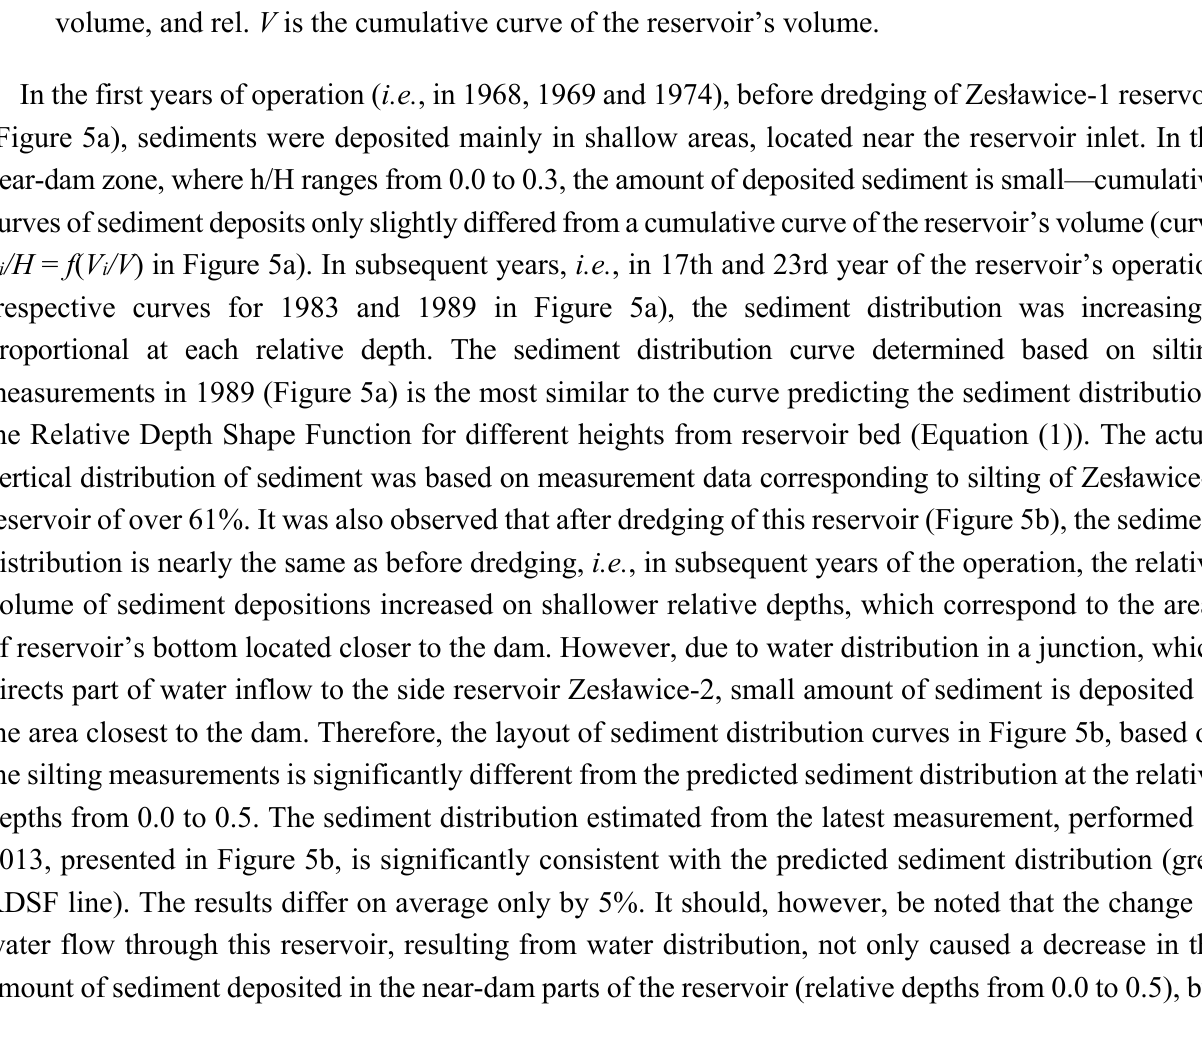
Figure 6. Comparison of cumulative depth of sediment deposition in reservoir Zes ł awice-2, described with function h i /H = f ( V i /V ), with relative cumulative sediment distribution described according to RDSF parameter; where h i /H is the relative depth, V i /V is the relative volume, and rel. V is the cumulative curve of the reservoir’s